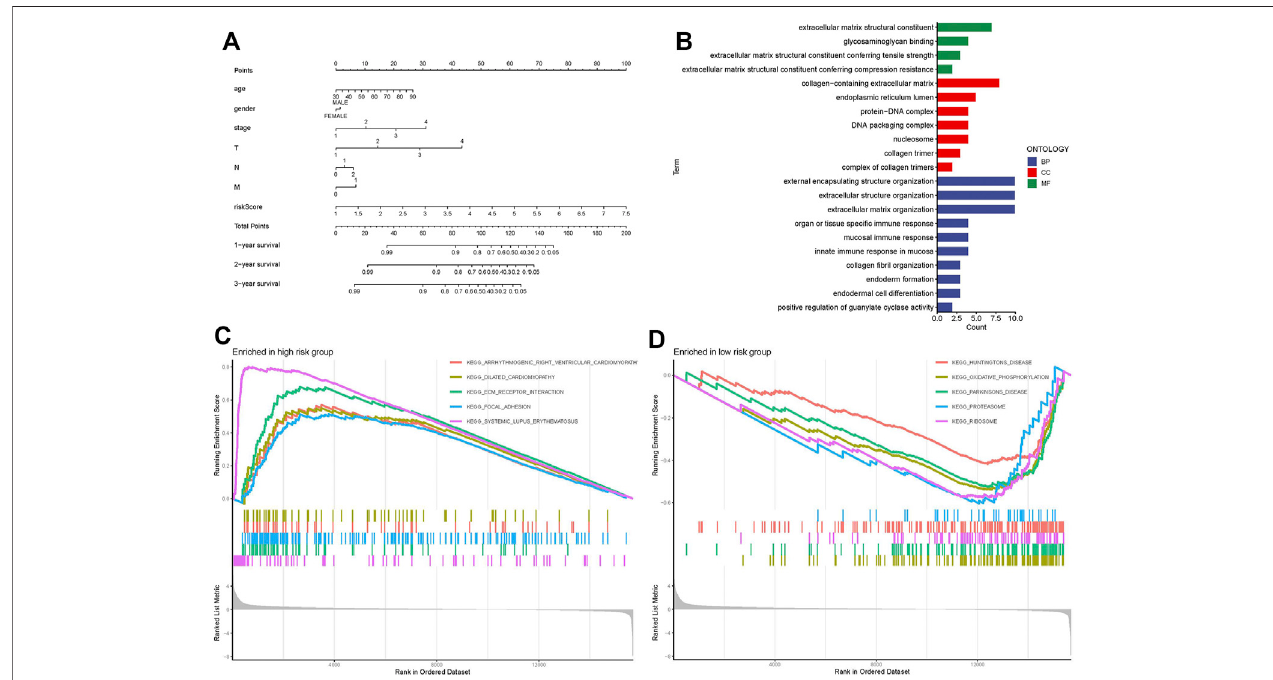
FIGURE 5 | Nomogram, GO, and KEGG analysis. (A) Nomogram. (B) GO enrichment analysis in risk genes. (C) KEGG enrichment analysis in the high-risk group. (D) KEGG enrichment analysis in the low-risk